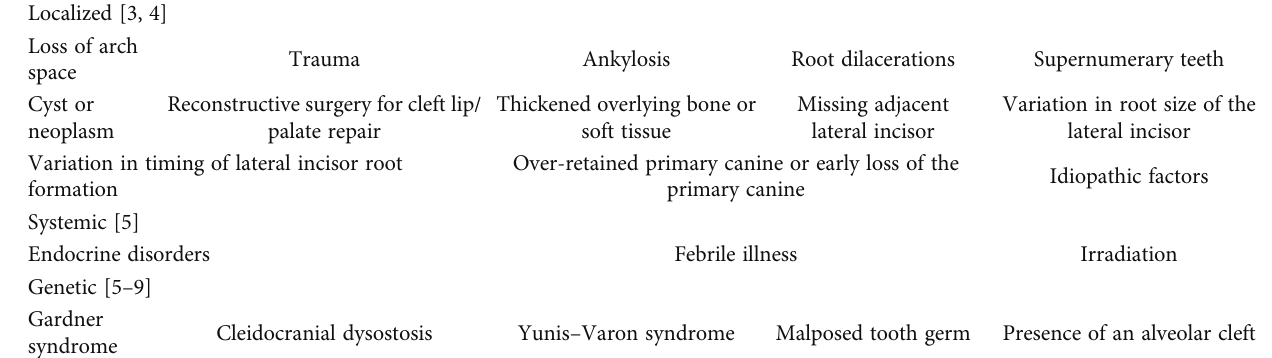
Table 1: Etiologic factors associated with impacted